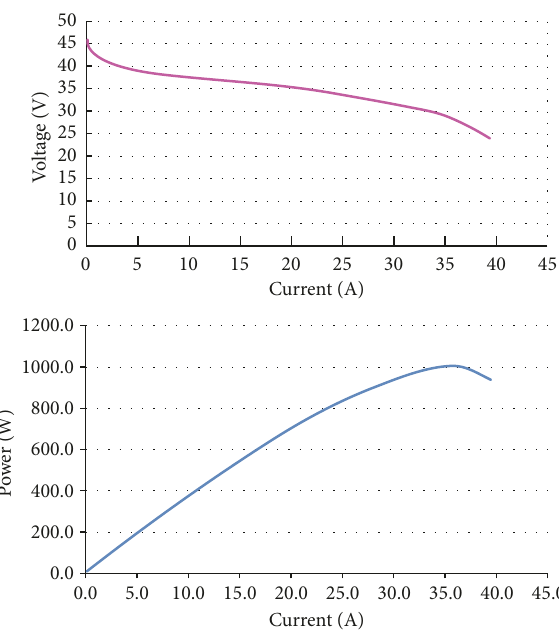
Figure 12: Polarization curves, voltage versus current and power versus current from data sheet